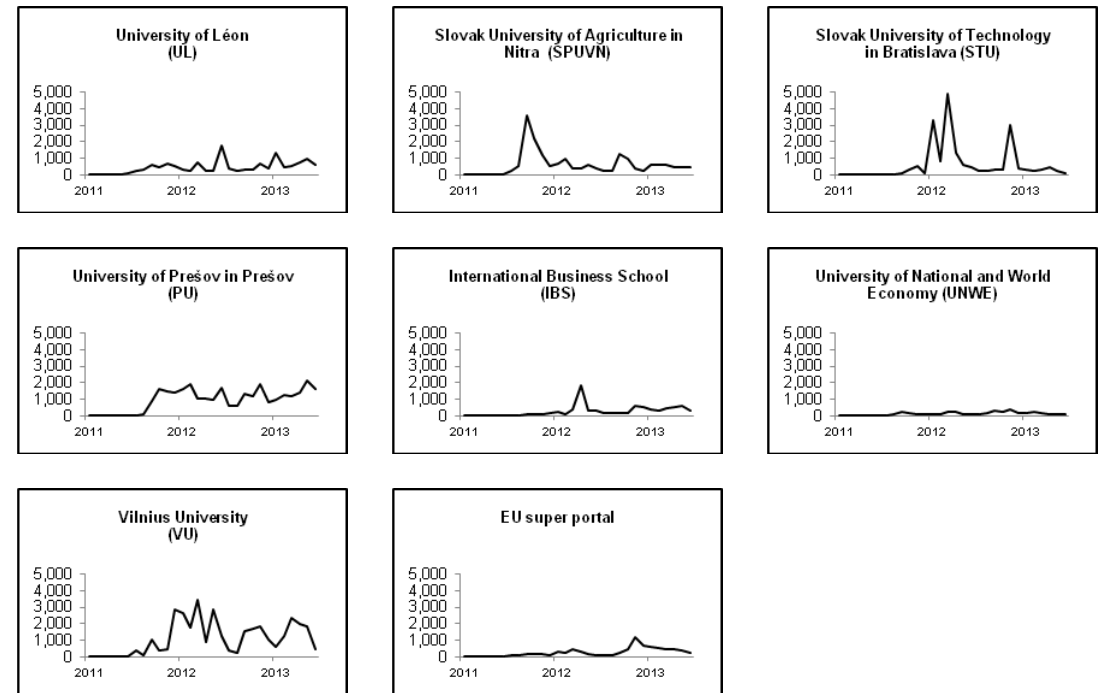
Figure 2: Monthly visits to all MyUniversity portals throughout the project period As can be seen, visits among the five Catalan trials (UAB, UB, UPC, UdG, and UdL) were